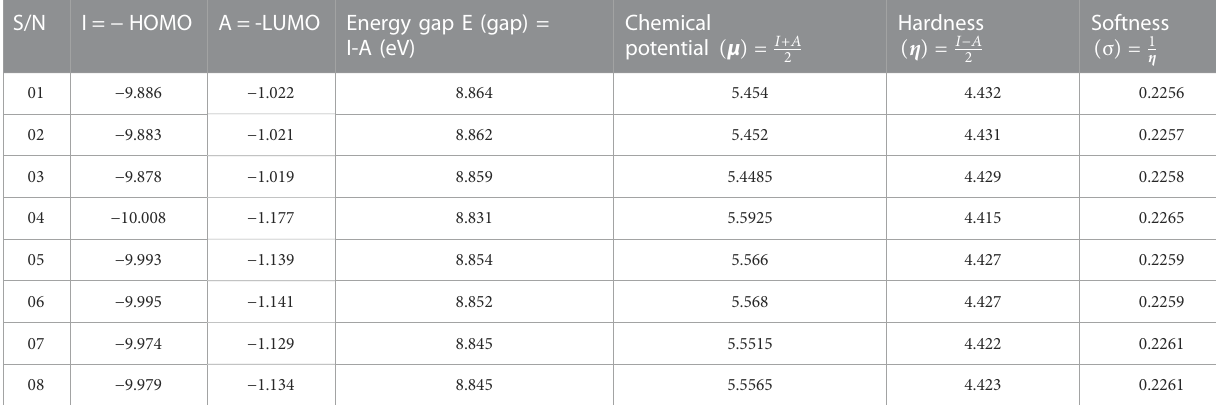
TABLE 2 Chemical reactivity descriptor analysis.